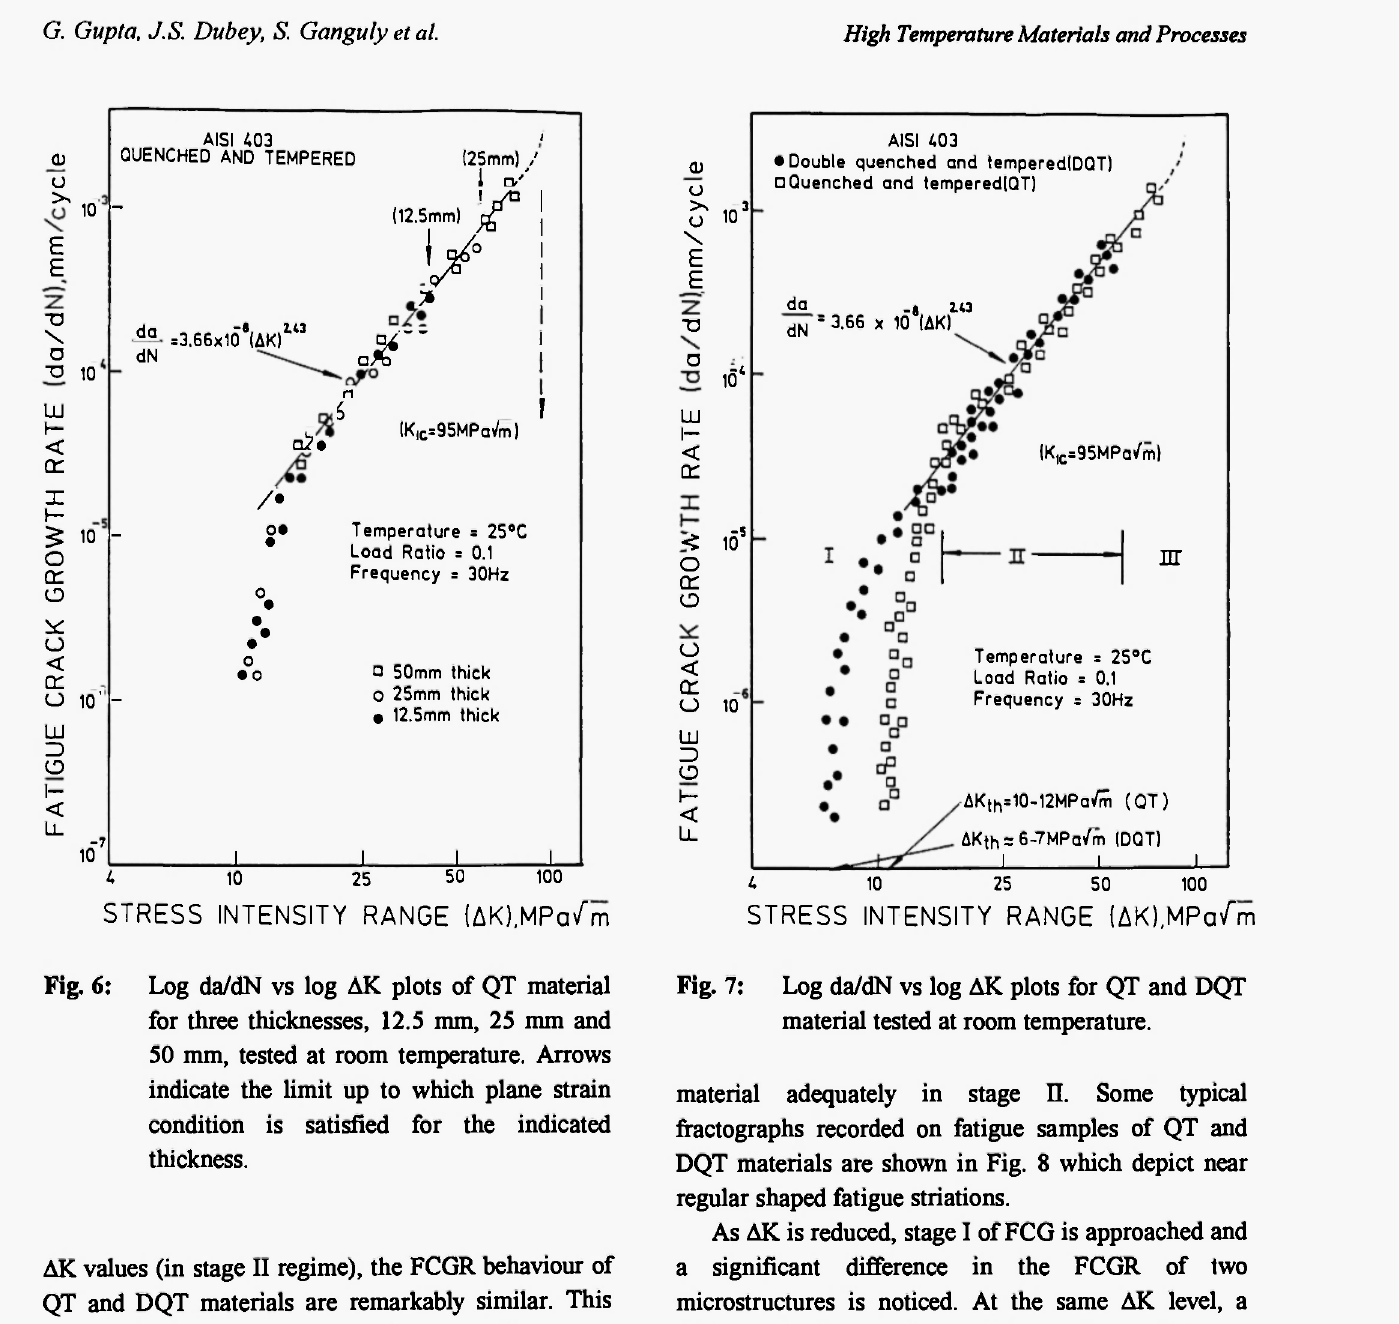
Fig. 6: Log da/dN vs log ΔΚ plots of QT material for three thicknesses, 12.5 mm, 25 mm and 50 mm, tested at room temperature. Arrows indicate the limit up to which plane strain condition is satisfied for the indicated thickness.